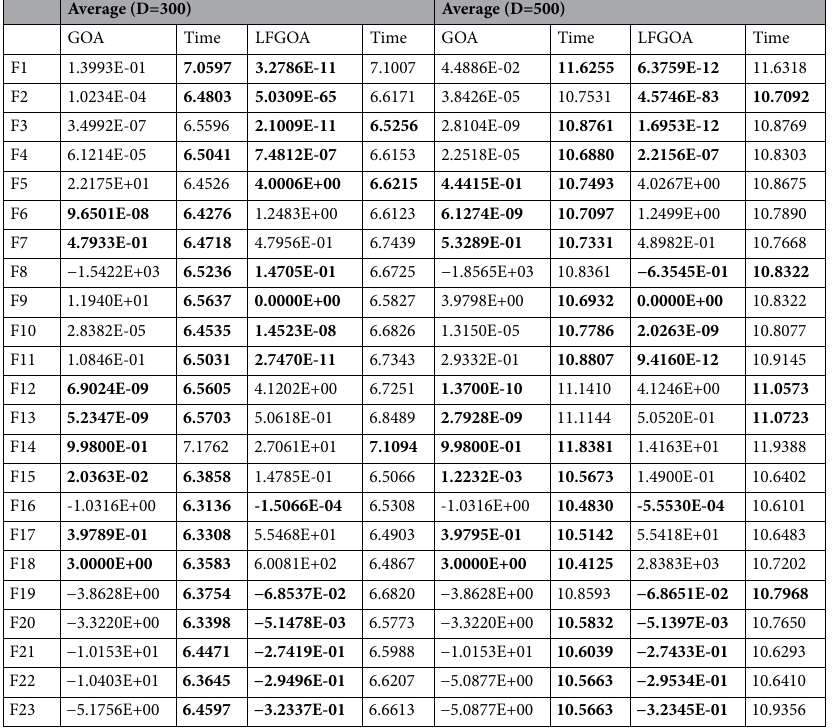
Table 10. The average values and consumed time under dimensions are equal to 300 and 500. The best of the comparison results are in [bold].